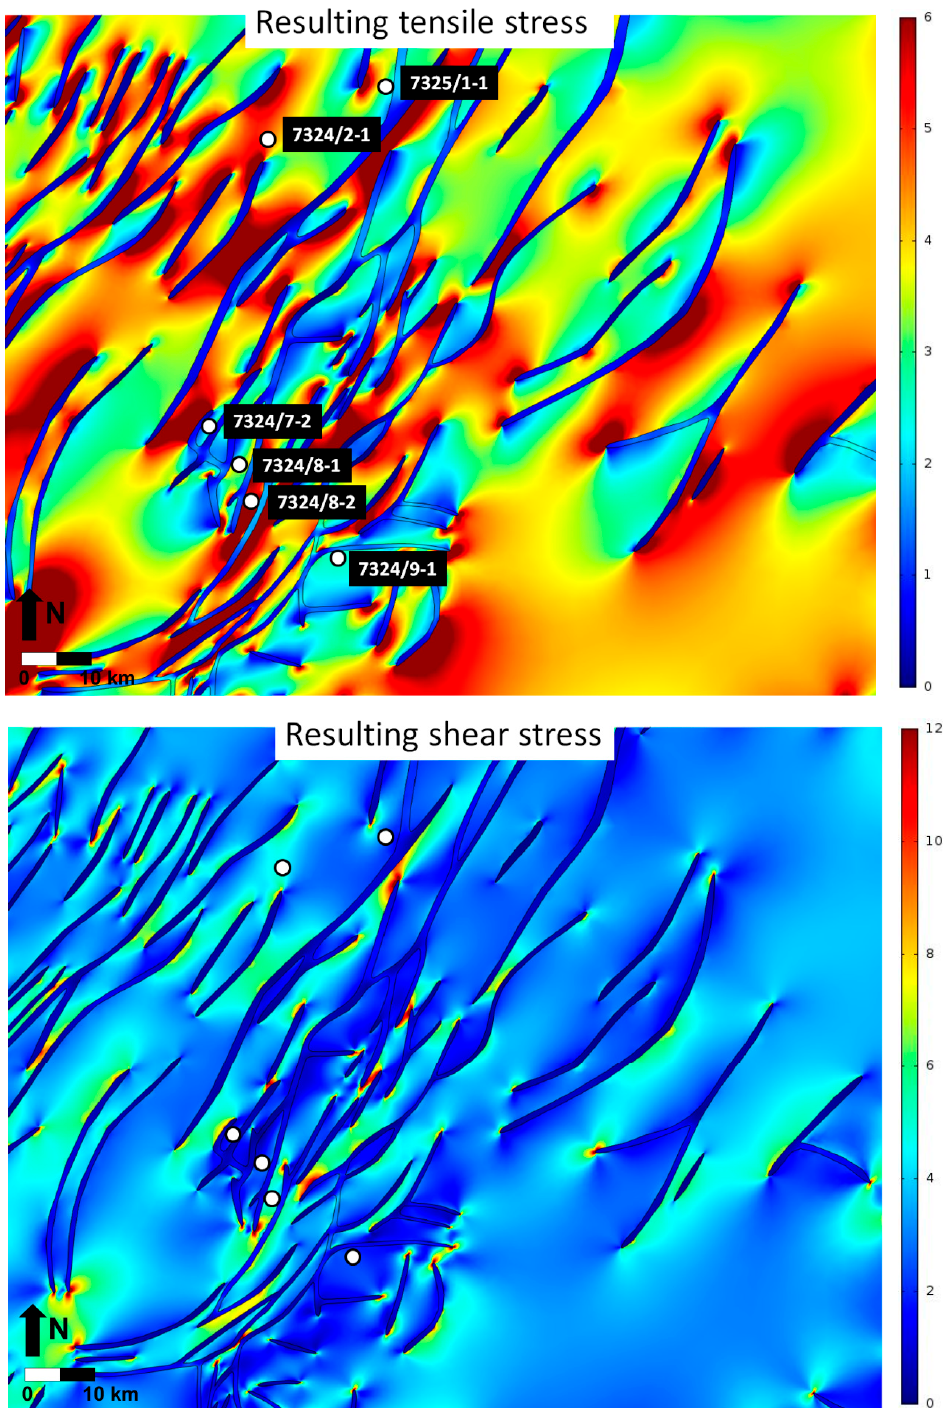
Figure 7. Stress models covering an area of 120 × 90 km in the Hoop Fault Complex, SW Barents Sea. The results include related exploration wells with data made public prior to 2017. Top : Resulting distribution of maximum principal tensile stress ( σ 3 ) during SW–NE extension due to deglaciation of LGM. Bottom : Resulting distribution of von Mises shear stress during flexure-related SW–NE extension. Scale in megapascals.